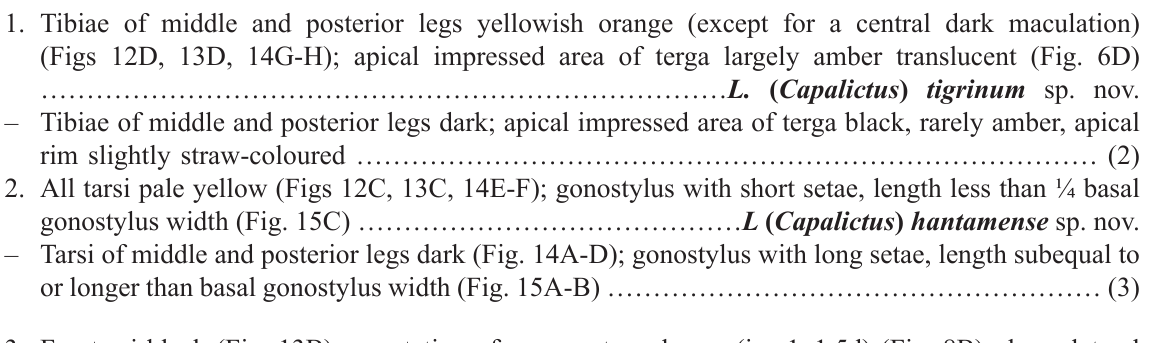
– Foretarsi yellowish (Fig. 13A); punctation of mesoscutum sparser (i = 3–4d) (Fig. 3B); dorso-lateral